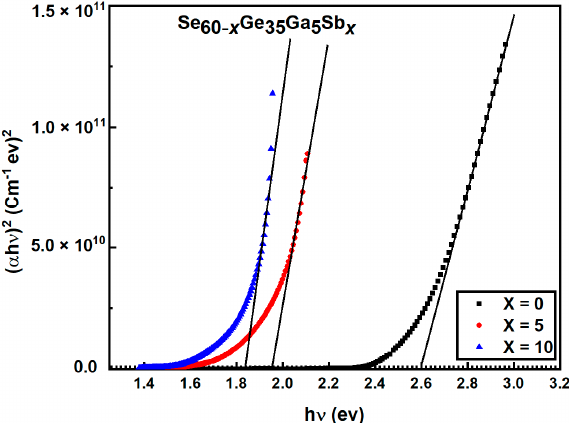
Figure 9. The relation of ( 𝛼ℎ𝜈) (cid:2870) with respect to ℎ𝜈 for Se 60 − x Ge 35 Ga 5 Sb x ( x = 0, 5, 10) films.